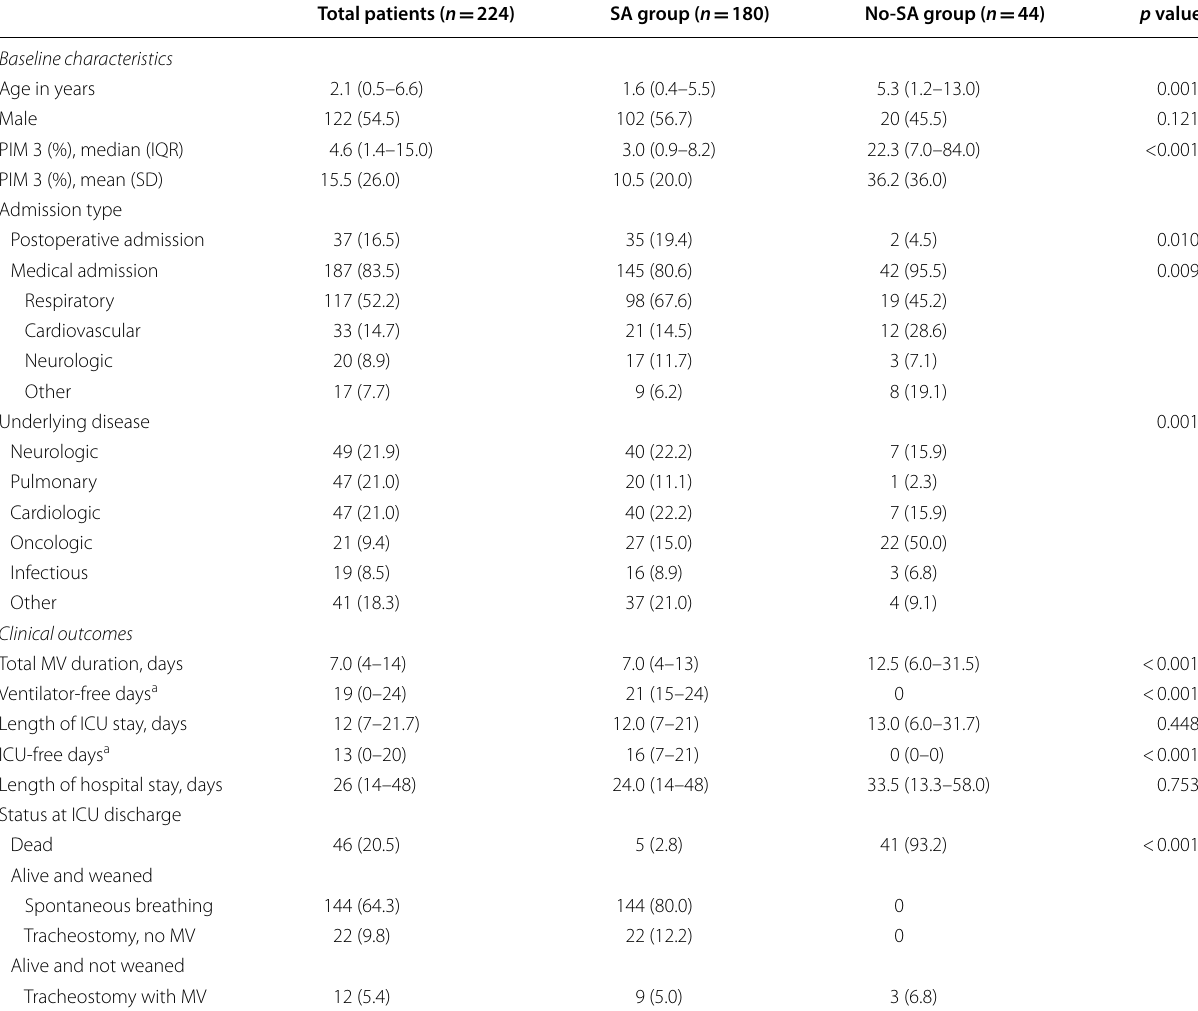
Table 1 Patient characteristics and outcomes according to separation